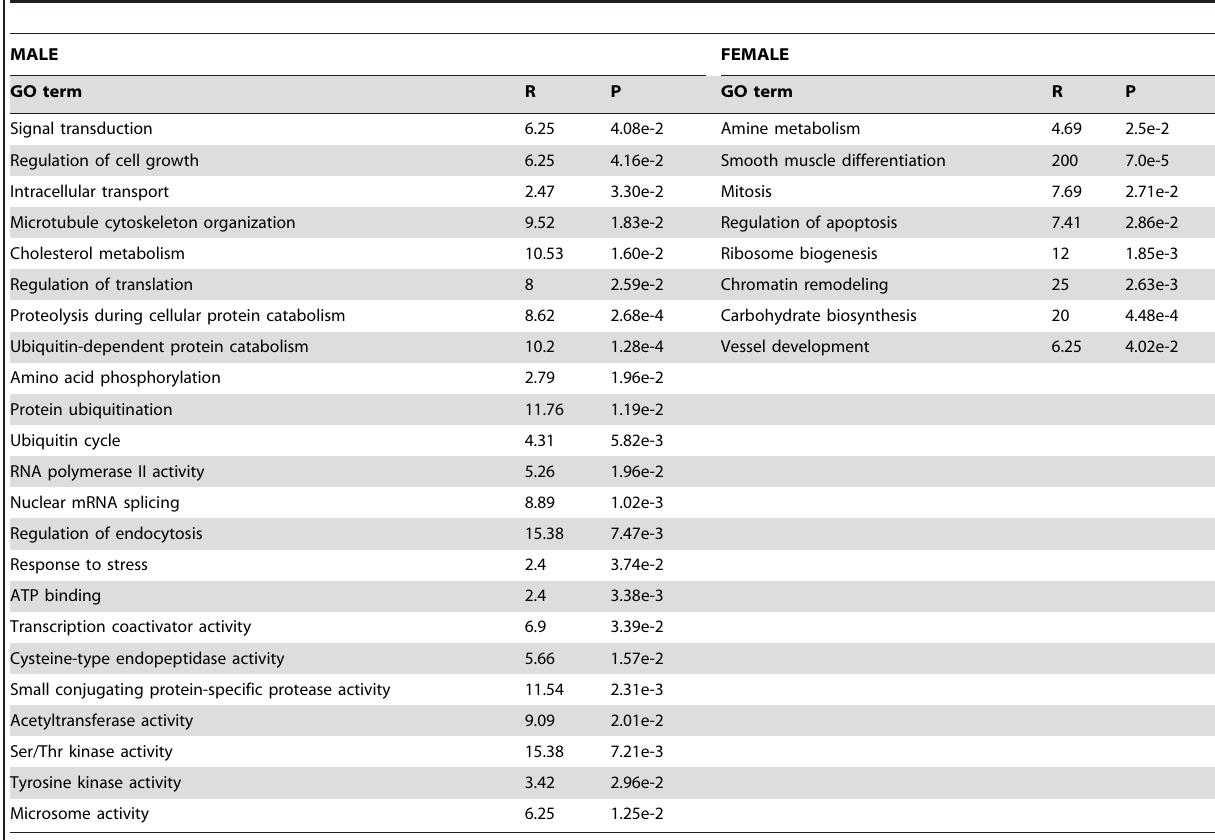
Table 1. Webgestalt GO term analysis of gonadal transcriptional response to intermittent fasting compared to 20% caloric restriction.